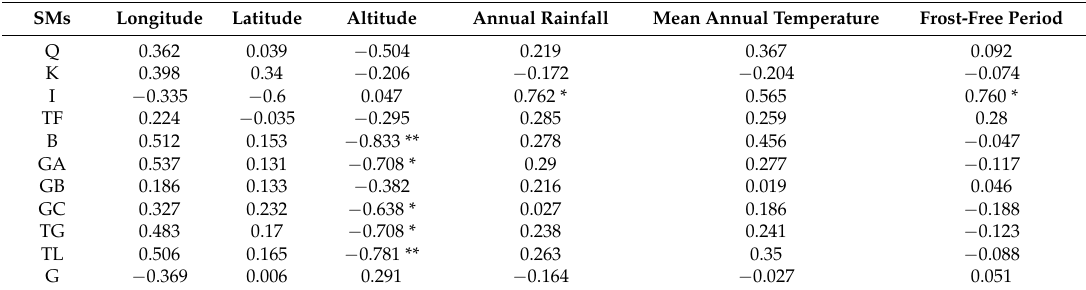
Table 4. The correlation between the concentrations of SMs and geographical climate factors, including longitude, latitude, altitude, annual rainfall, mean annual temperature and frost-free period.